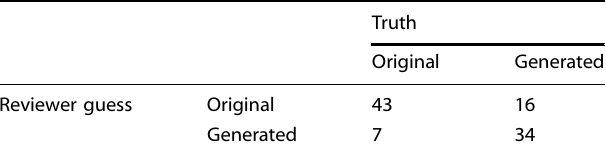
Table 1. Human reviewer scoring for whether abstracts were real or generated, along with